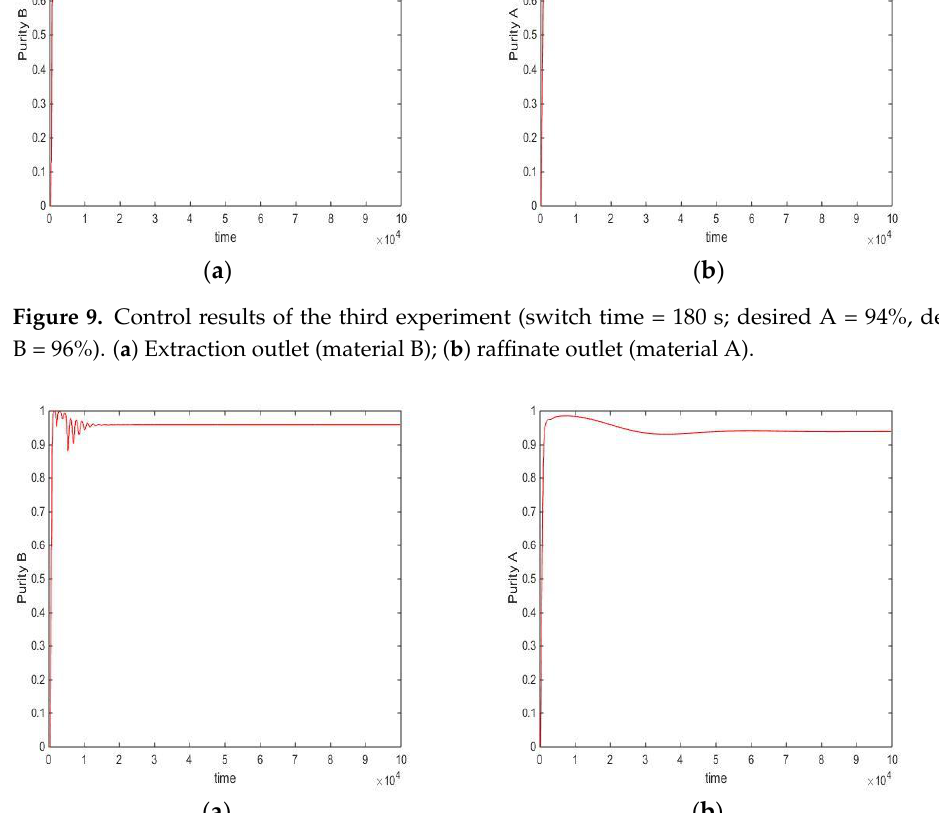
Figure 10. Control results of the fourth experiment (switch time = 180 s; desired A = 93%, desired B